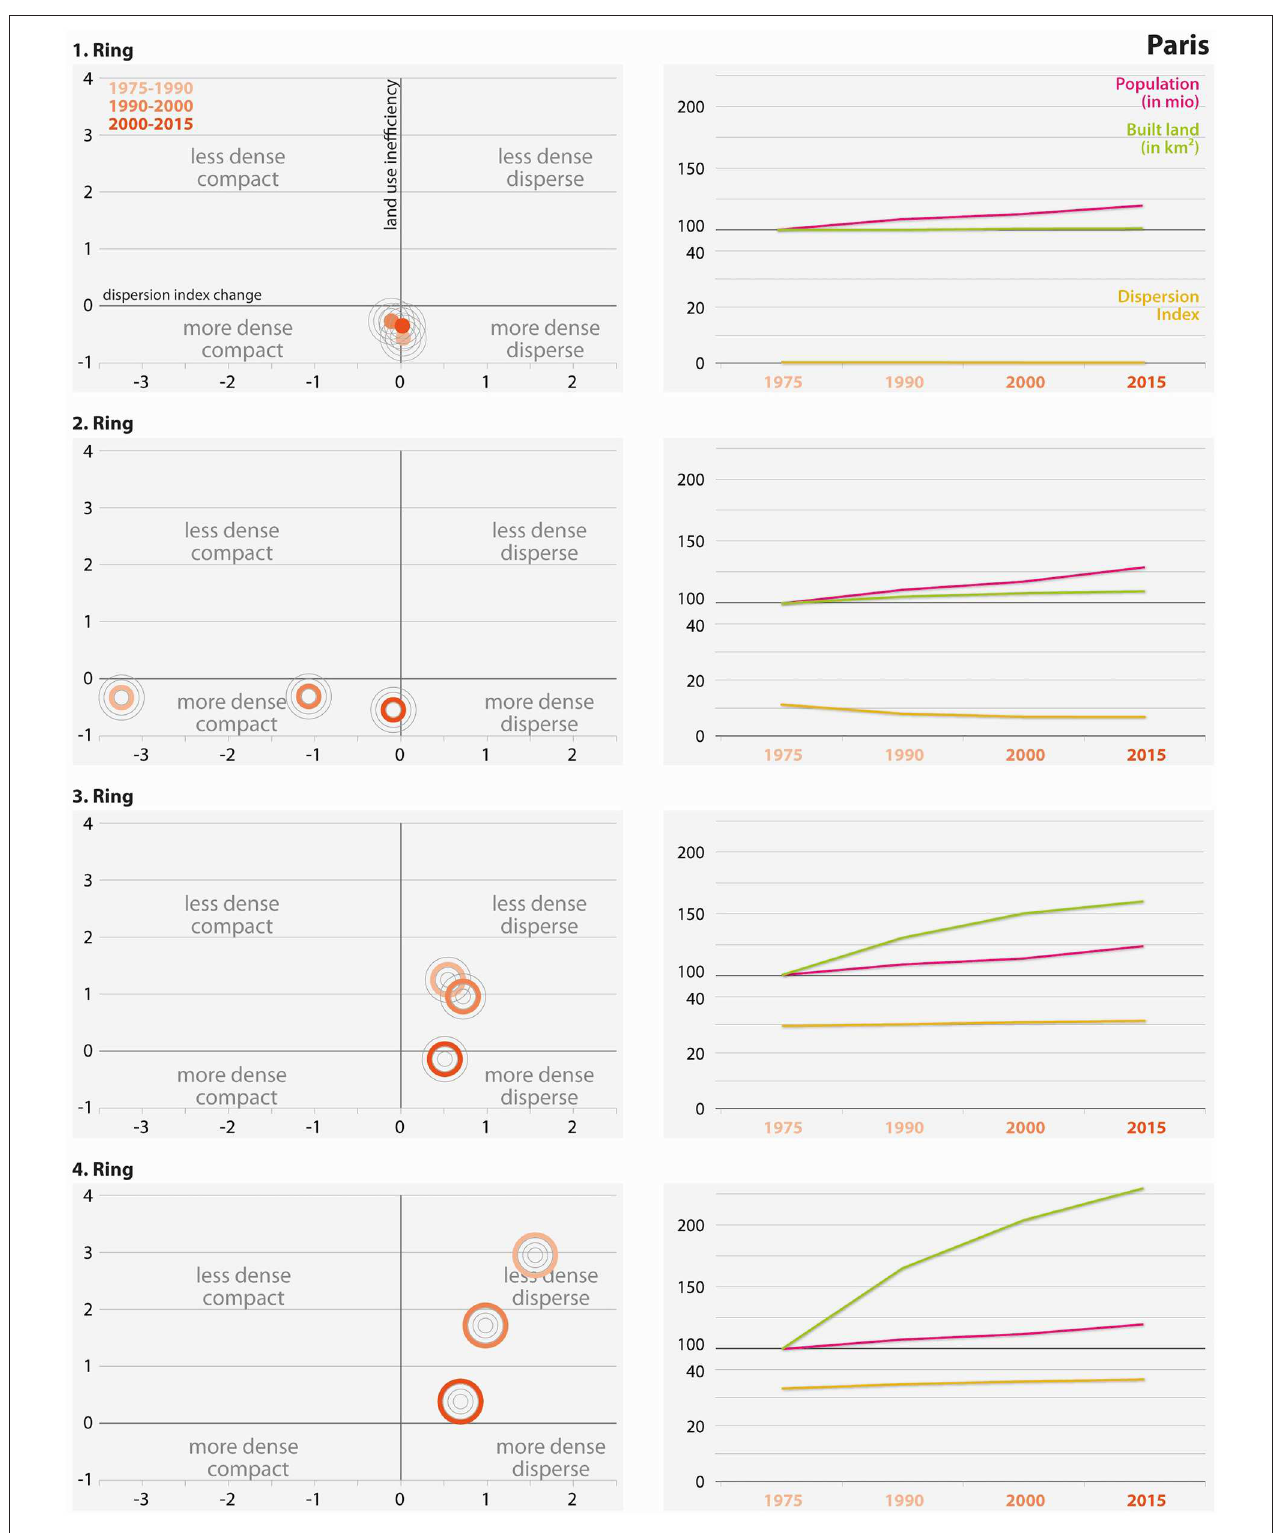
FIGURE 9 | Urbanization trends for Paris divided into the four rings. The line charts illustrate the corresponding development of built-up land, population, and dispersion index over time.